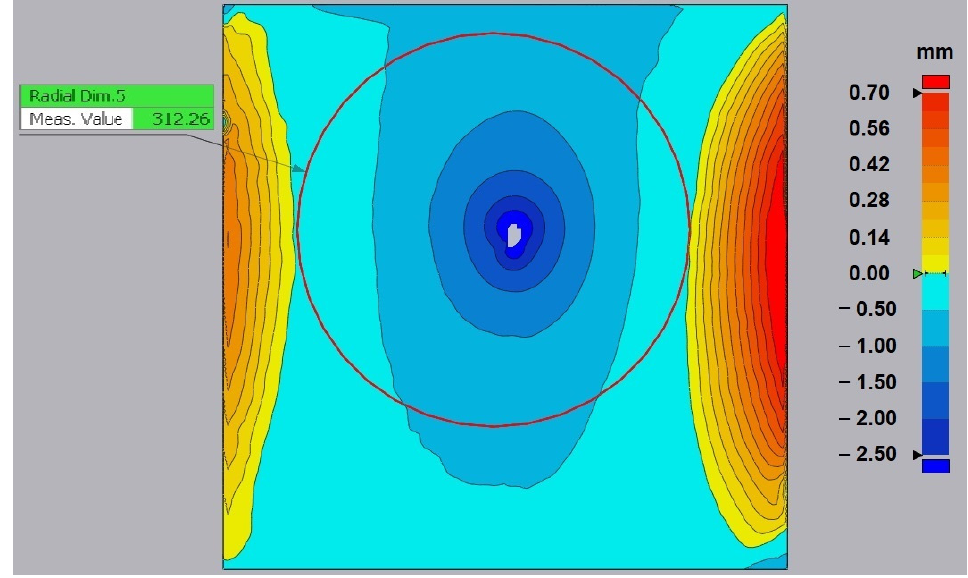
Figure 10. Deformation analysis on a panel 500 × 500 mm with an open window of 450 × 450 mm, and threshold diameter: test 5 of Table 2.